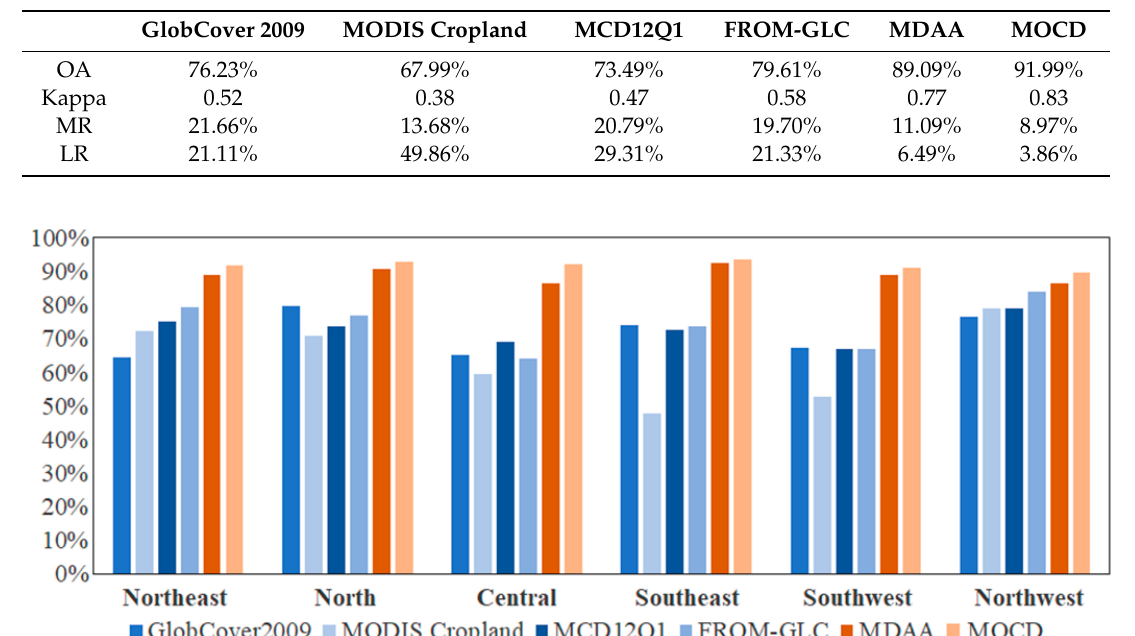
Figure 8. Overall accuracy of the spatial positioning in different geo-regions for the cropland products.